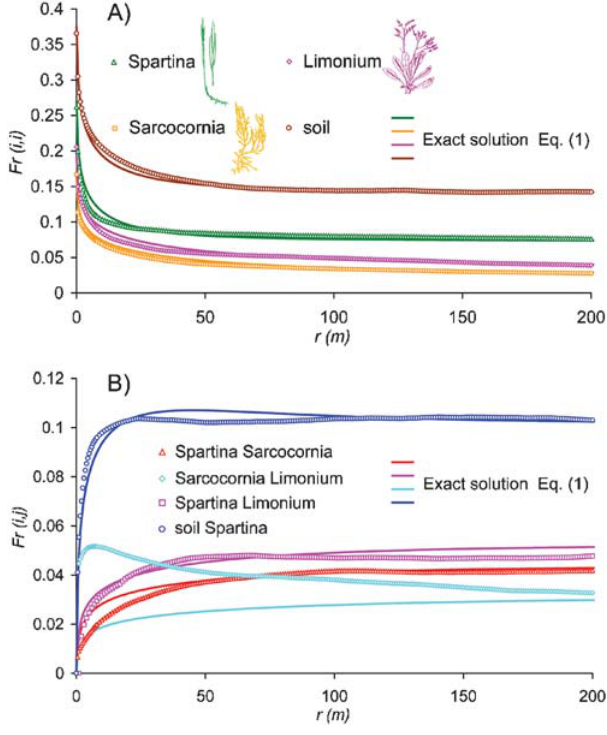
Figure 2. Beta-diversity of intertidal vegetation species. The solid symbols represent the probability of occurrence of species i and j at two sites separated by a distance r as computed from the vegetation distributions of Figure 1. The solid lines are plots of eqs. (1) from the model fitted on observations. Panel a) refers to the case in which i=j , (conspecific sites). In panel b), referring to the case i ? j , only one beta- diversity curve involving soil was indicated for clarity, the remaining ones being